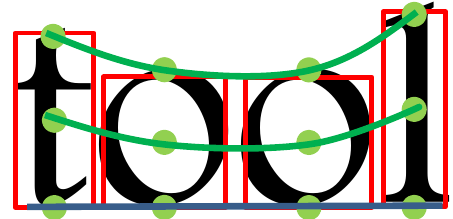
Figure 6. Example of polynomial regression using different reference points.